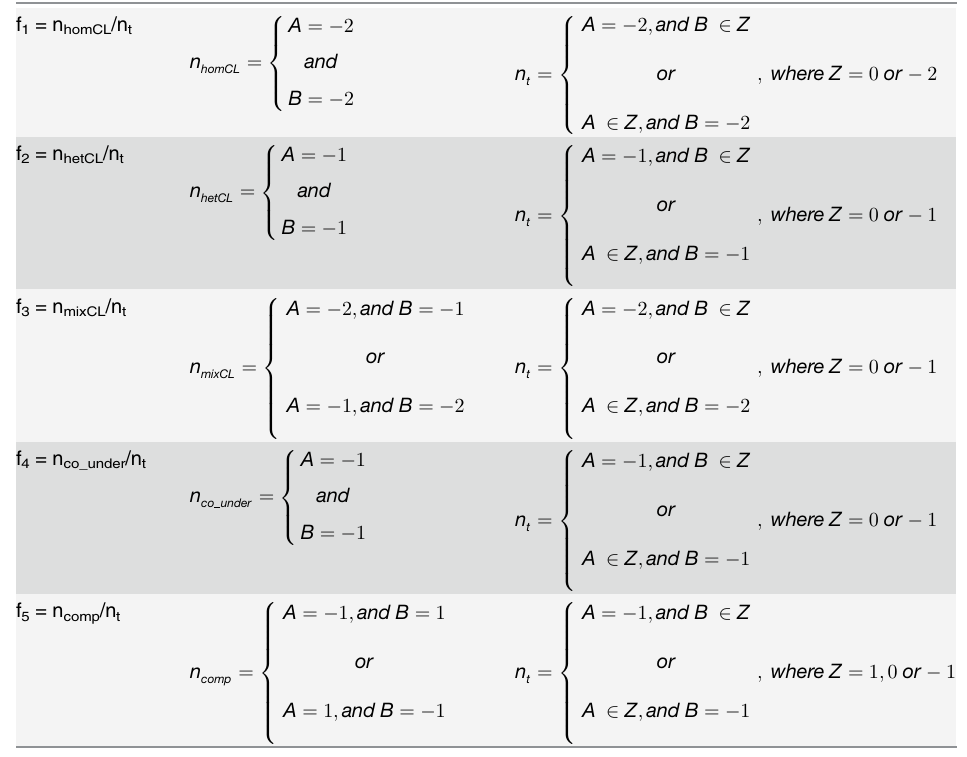
Table 1. Five fractions derived from genomic variations for SL interaction